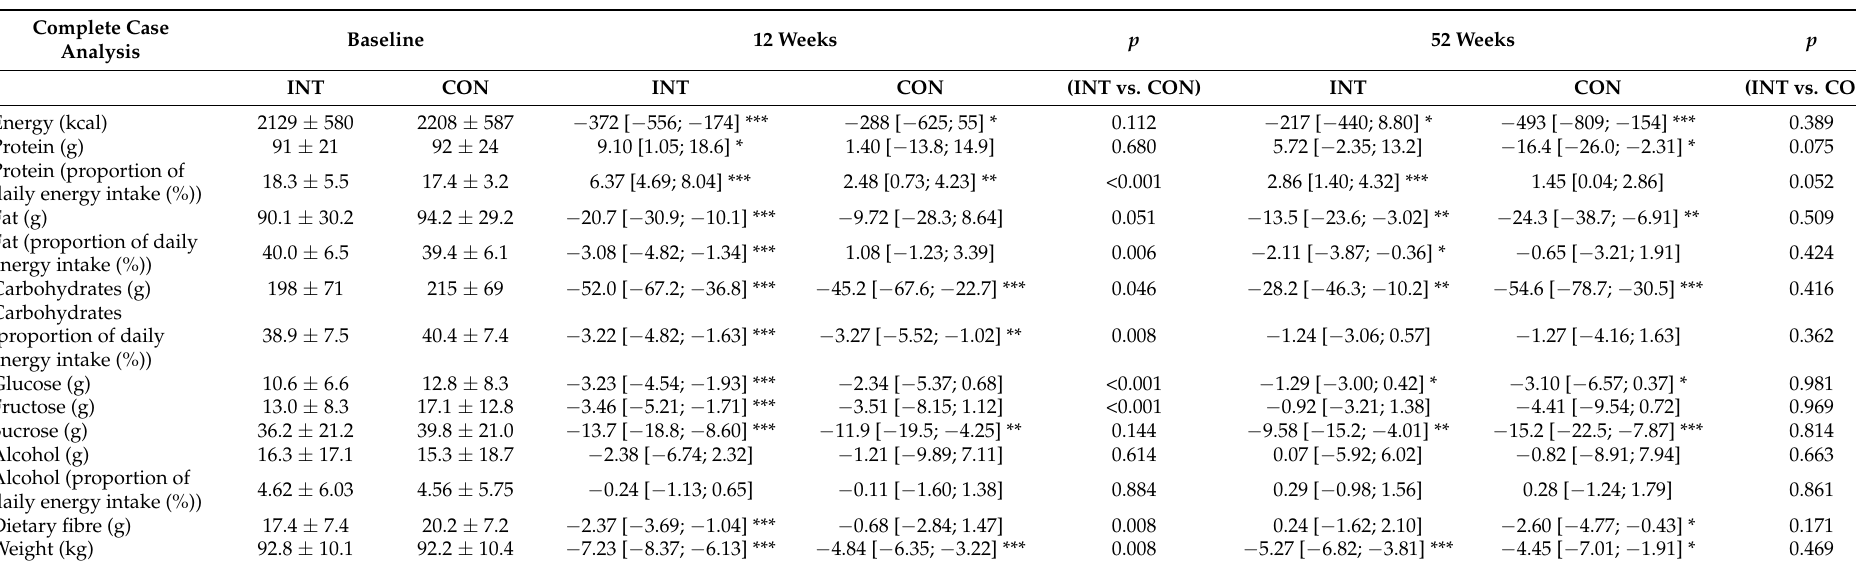
Table 2. Intra and intergroup changes of dietary intake data in the INT and CON group after 12 and 52 weeks of intervention (complete case